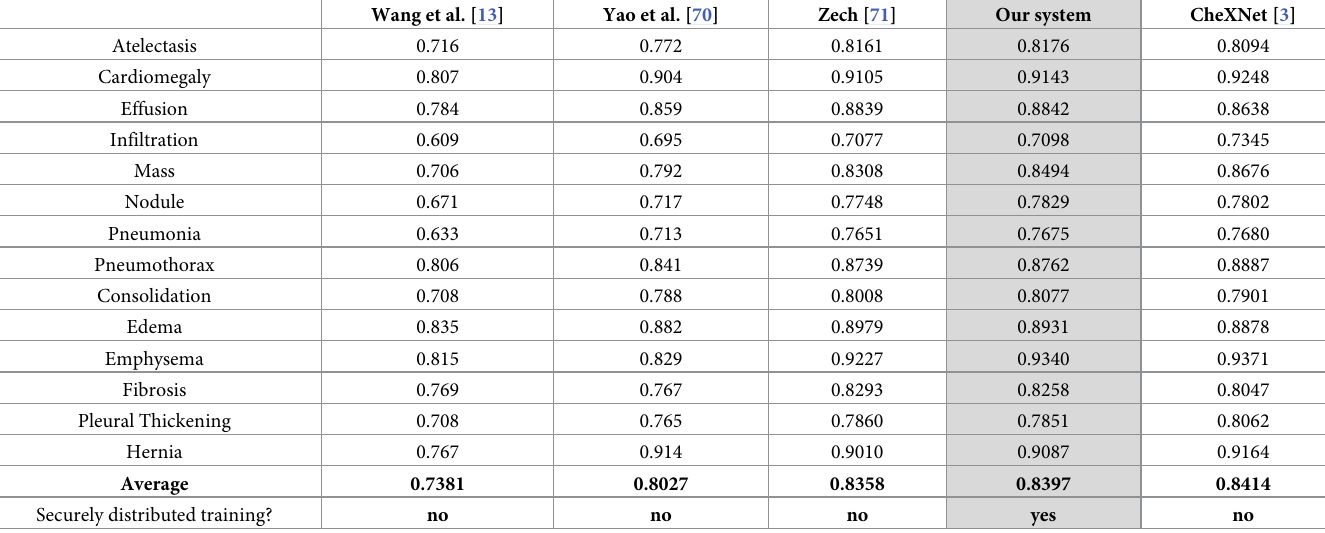
Table 4. Area-under-the-curve (AUC) scores of learning methods on